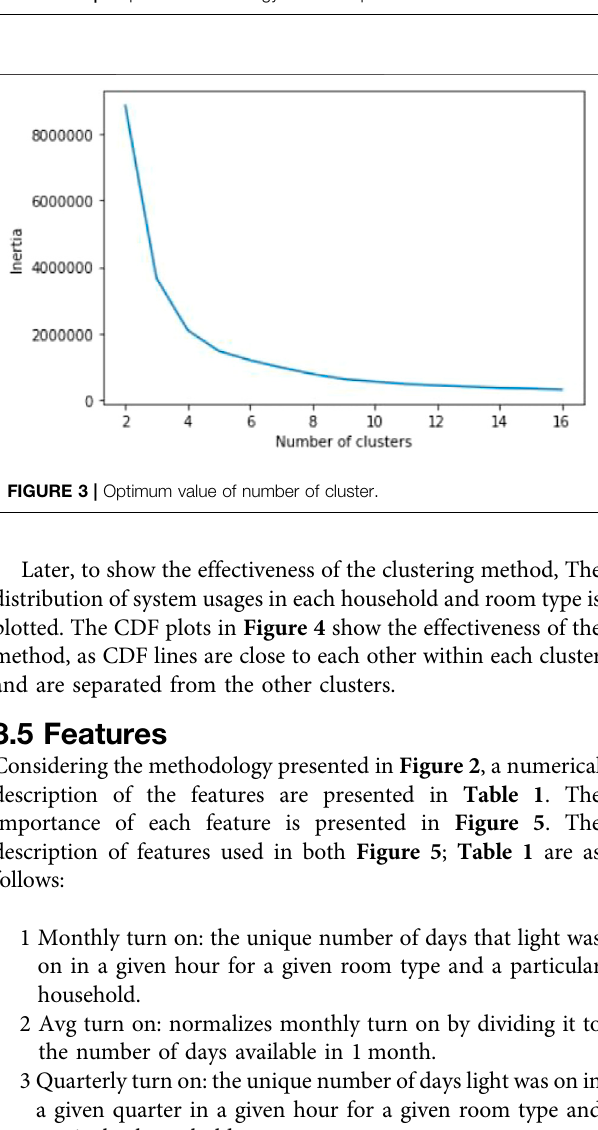
FIGURE 2 | Proposed methodology for scene prediction.